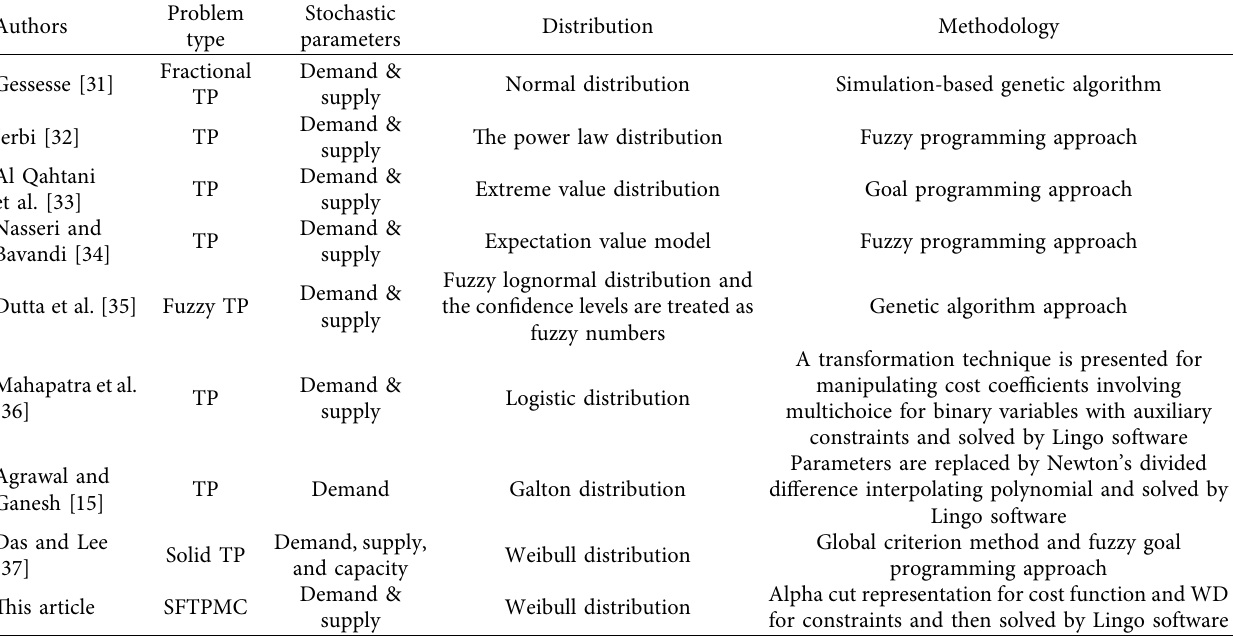
Table 1: Comparison of the approach to the present